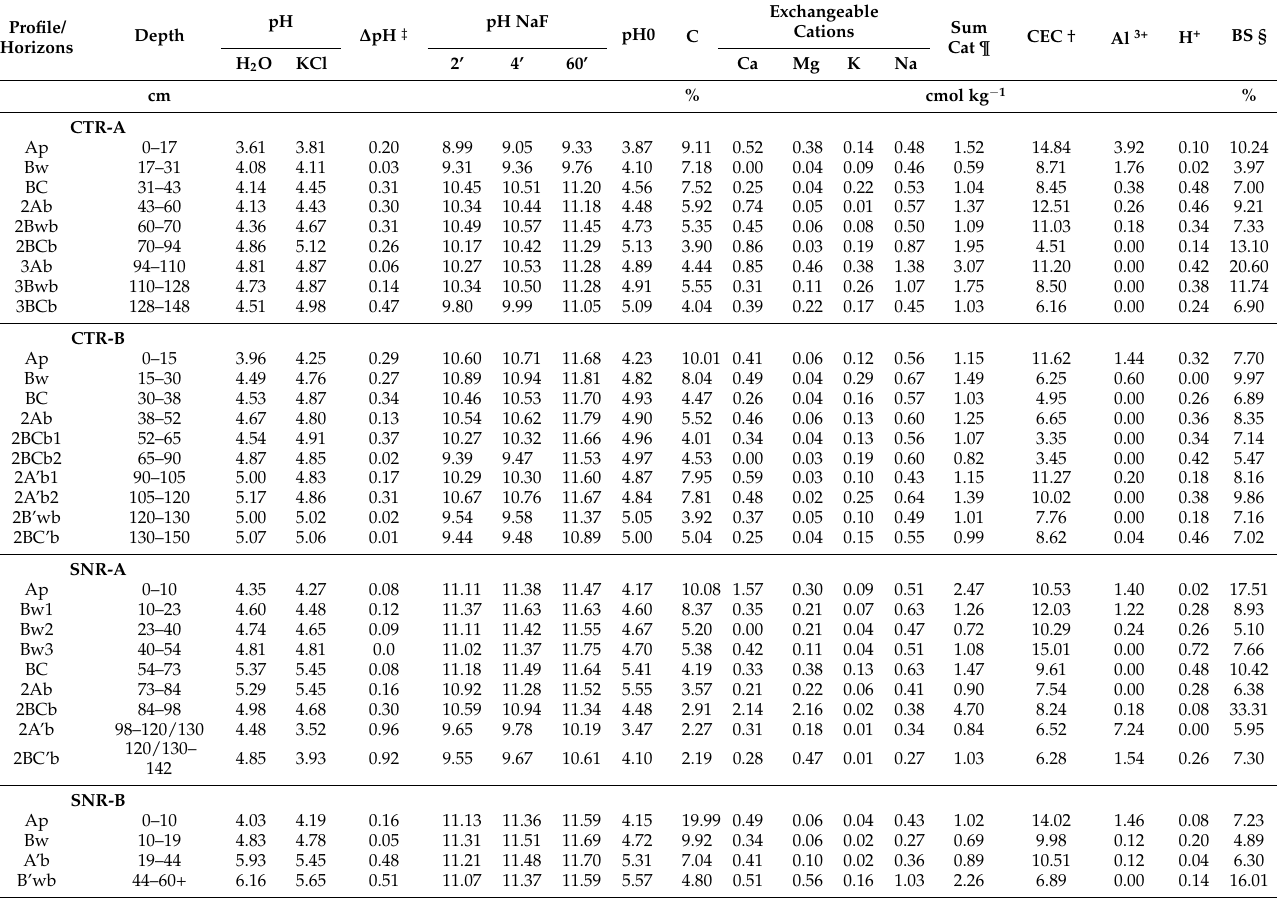
Table 5. The pH, point zero charge, exchangeable cations, and cation exchange capacity of soils with different agro-climatic zones, of different types, and with different ages of parent